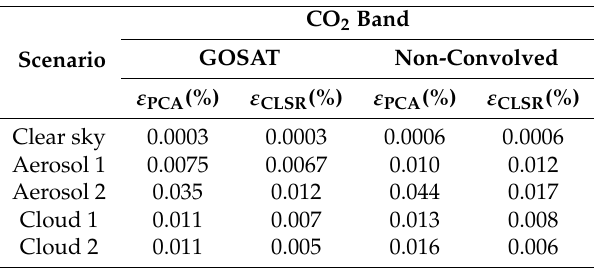
Table 8. Mean relative error ε for the convolved spectra compared with the multi-stream spectra for the PCA-based and CLSR methods and for the different atmospheric scenarios considered for the CO 2 band. In all cases, the low-stream model considered is the two-stream model. The instrument analyzed is GOSAT, which is compared with the non-convolved